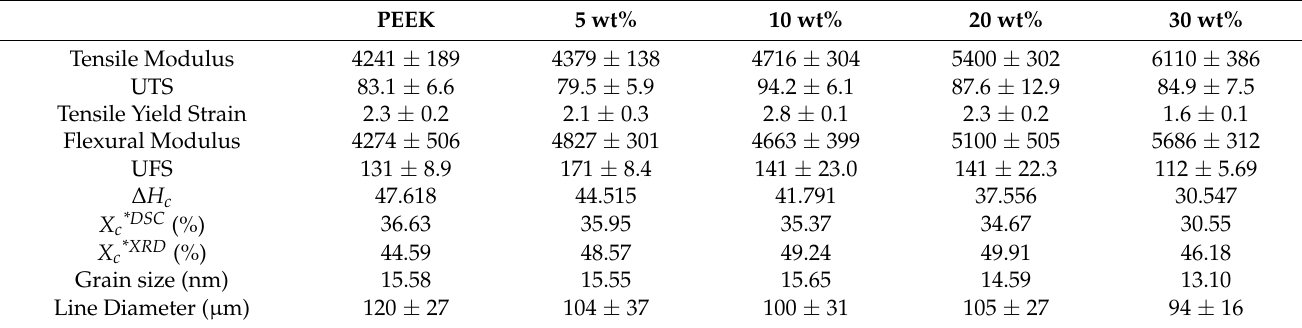
Figure 3. Mechanical properties of the samples: ( a ) tensile strength, ( b ) tensile modulus, and ( c ) flexural modulus. Table 2. Summary of mechanical and microstructural properties for the 3DP